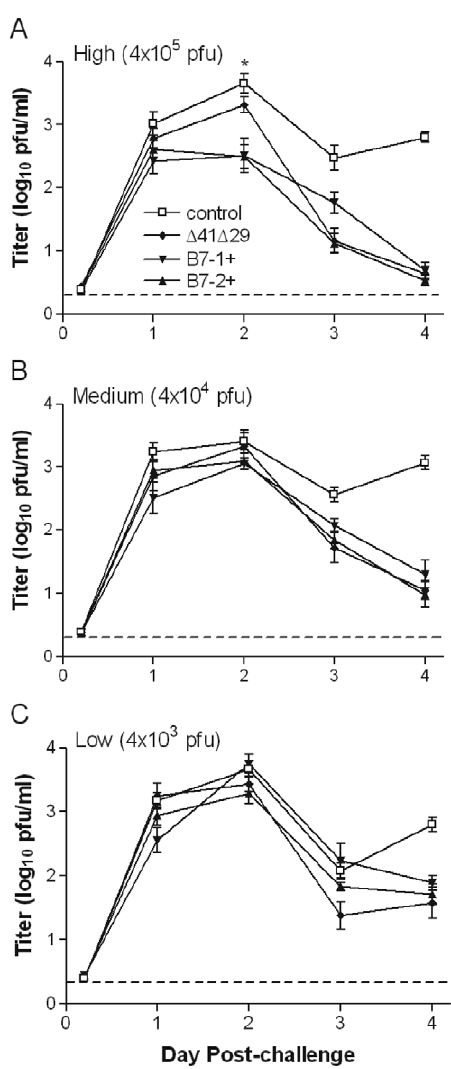
Figure 4. Titer of challenge virus shed from the corneal epithelium. Groups of BALB/c mice were immunized with A) high, B) medium or C) low doses of the indicated virus or control supernatant. All groups were challenged 1 mo after immunization by inoculation of HSV-1 mP onto the corneas and mouse eyes were swabbed at the indicated times post-challenge. Titers of virus collected on swabs were determined by standard plaque assay. Data represent the geometric mean 6 SEM for 10 to 12 samples per group at each dose, compiled from 2 independent experiments. *, P=0.002 to 0.014 for D 41 D 29 compared with D 41 D 29B7-1 and D 41 D 29B7-2. Dashed line indicates limit of detection in the plaque assay.